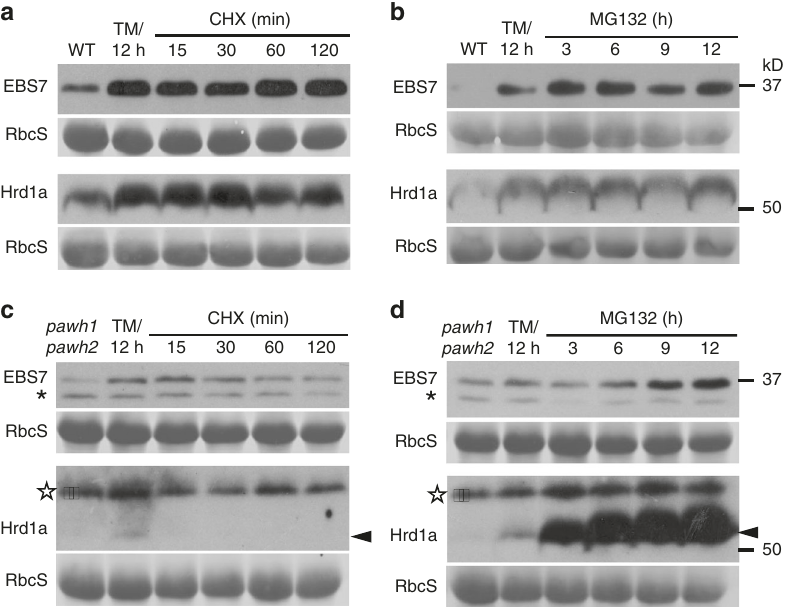
Fig. 6 The pawh1 pawh2 double mutation reduces the stability of EBS7 and Hrd1a. a – d Immunoblot analysis of EBS7 and Hrd1a in the wild-type ( a , b ) and pawh1 pawh2 double mutant ( c , d ). Total proteins were extracted from 10-day-old seedlings that were initially treated with 5 μ g/mL TM for 12 h and subsequently treated with 180 μ M CHX ( a , c ) or 80 μ M MG132 ( b , d ) for different durations, separated by SDS-PAGE, and analyzed by immunoblotting using anti-EBS7 and anti-Hrd1a antibodies. In each immunoblotting experiment, the RbcS-labeled strip was used as a loading control. Asterisks and stars denote cross-reacting bands to anti-EBS7 and anti-Hrd1a antibodies, respectively, while arrows indicate the Hrd1a band. Source data are provided as a Source Data fi